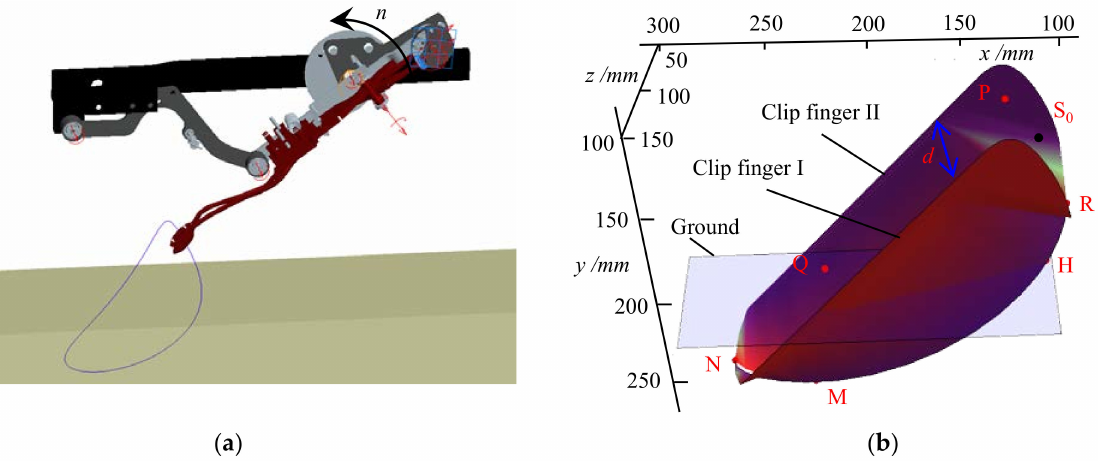
Figure 9. The kinematics simulation analysis of the slip taking-planting mechanism. ( a ) Simulation model. ( b ) Trajectory of the clip finger in the slip taking-planting mechanism. Note: P , the uppermost point of the planting track; M, the deepest point of the planting track; N, the farthest point of the planting track; R, the nearest point of the planting track; H, the penetrating point; Q, the unearthed point; S 0 , the initial position; d , the distance between the trajectories of clip finger I and